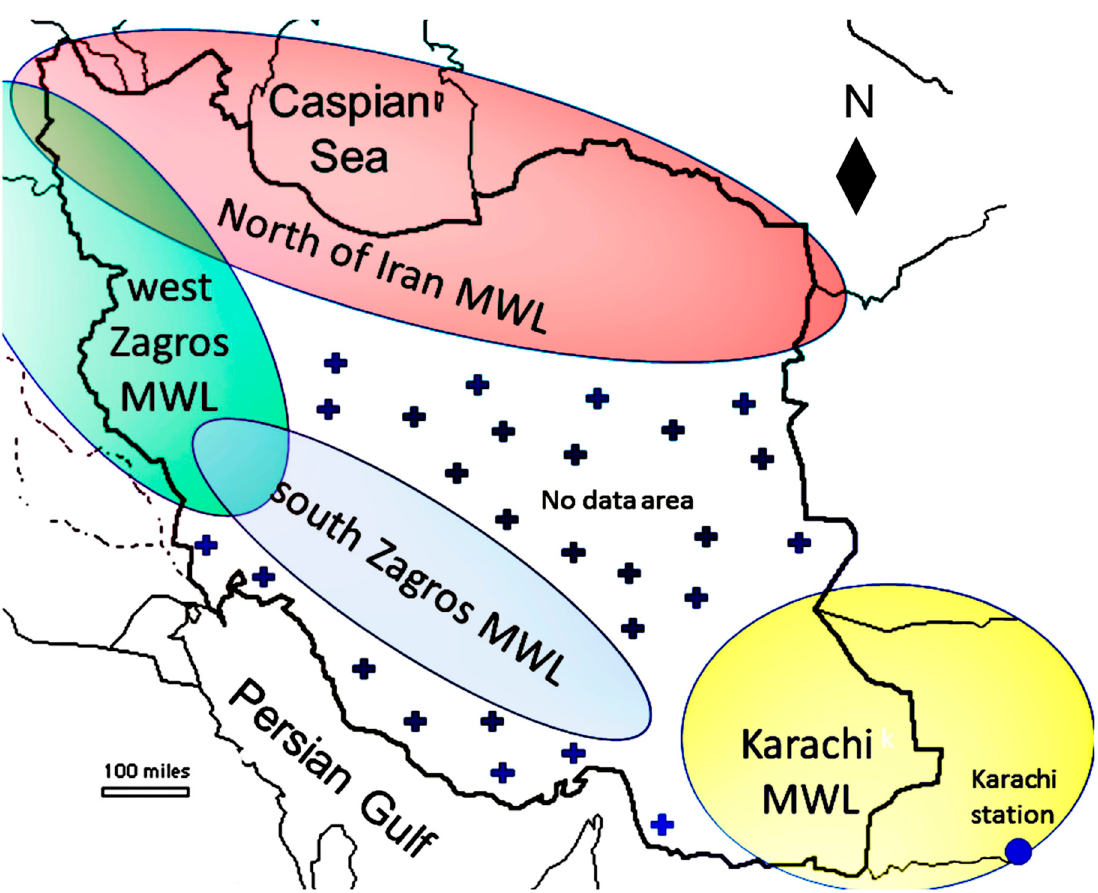
Figure 5. Map of areas covered by Iran MWLs and areas with no suggested MWLs. (The plus signs cover the areas with no suggested MWLs in